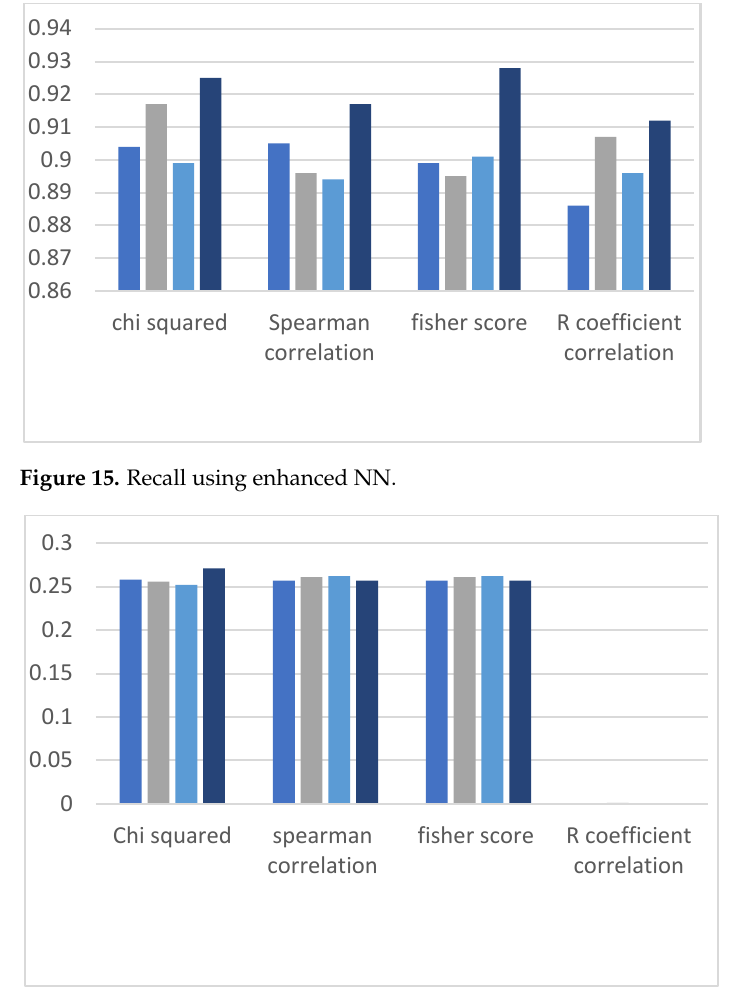
Figure 16. Recall using enhanced LR.